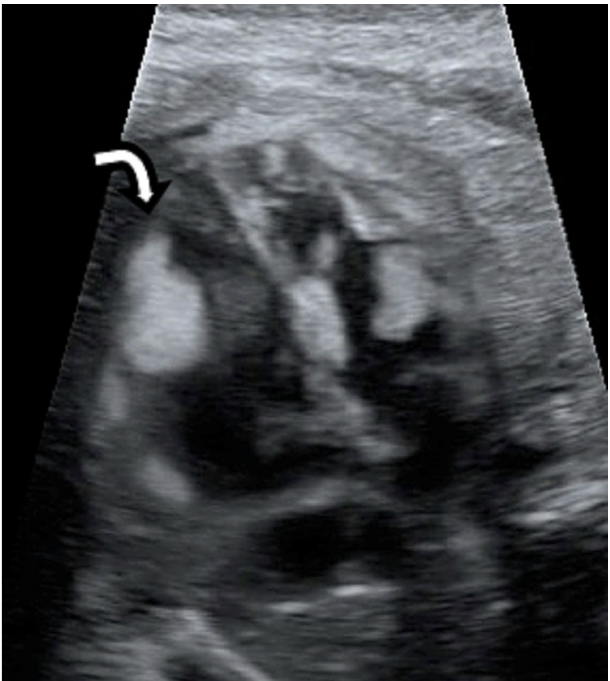
Fig. 1 - Two-dimensional echocardiographic at 22 weeks of gestation in the “four-chamber” view showing a rhabdomyoma in the internal wall of fetal left ventricle (white